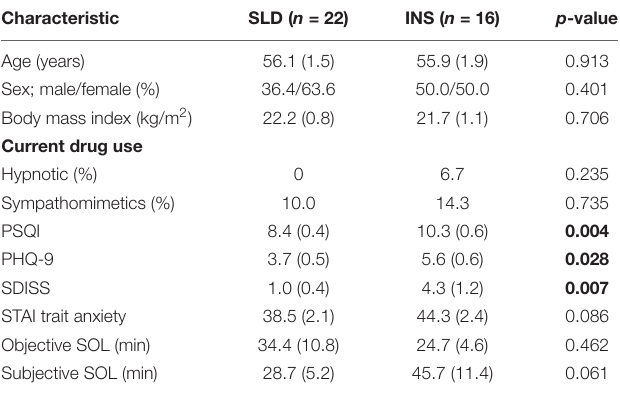
TABLE 1 | The participant’s demographic and clinical characteristics. TABLE 2 | Summary of the statistical results in the objective and subjective sleep onset latency analyses.